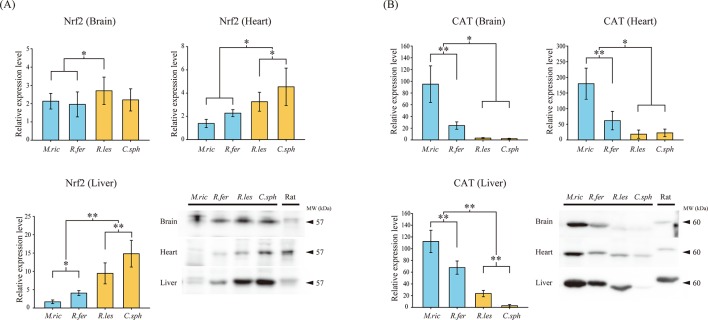
The levels of Nrf2 protein and catalase (CAT) in the brain, heart and liver of four bats species.Four bats species were used in this study and are two insectivorous bats (M.ric: Myotis ricketti; R.fer: Rhinolophus ferrumequinum) and two Old World fruit bats (R.les: Rousettus leschenaultia; C.sph: Cynopterus sphinx). Protein level of (A) Nrf2 protein and (B) catalase in representative bat species and rats (positive control) were determined by Western blotting. Relative levels are presented as mean ± SD. Arrows indicate the predicted molecular weights (kDa) of the proteins. Statistical significance of the differences among species were determined by one-way ANOVA with post hoc Holm-Sidak tests: *P < 0.05, **P < 0.001.